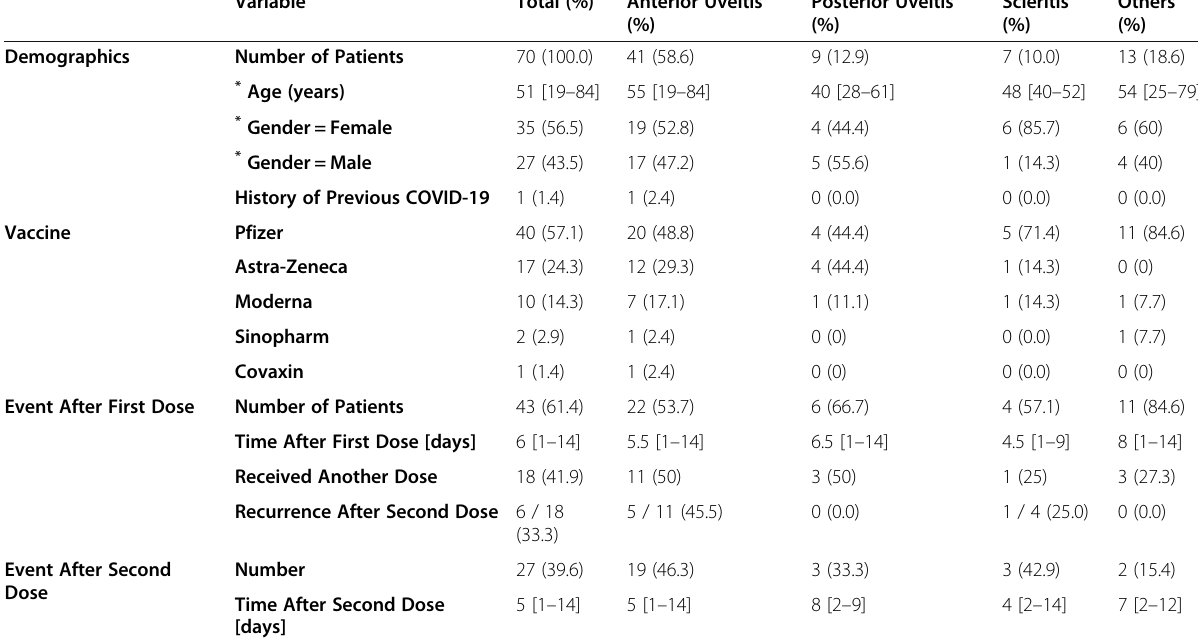
Variable Total (%) Anterior Uveitis